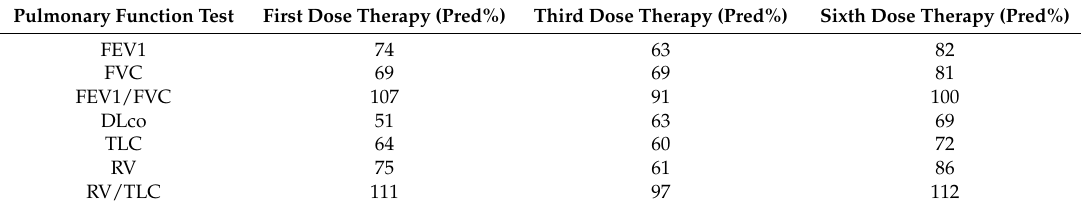
Table 1. Pulmonary function test results after first, third, and sixth dose of pulse steroid therapy. Pulmonary Function Test (Pred%)